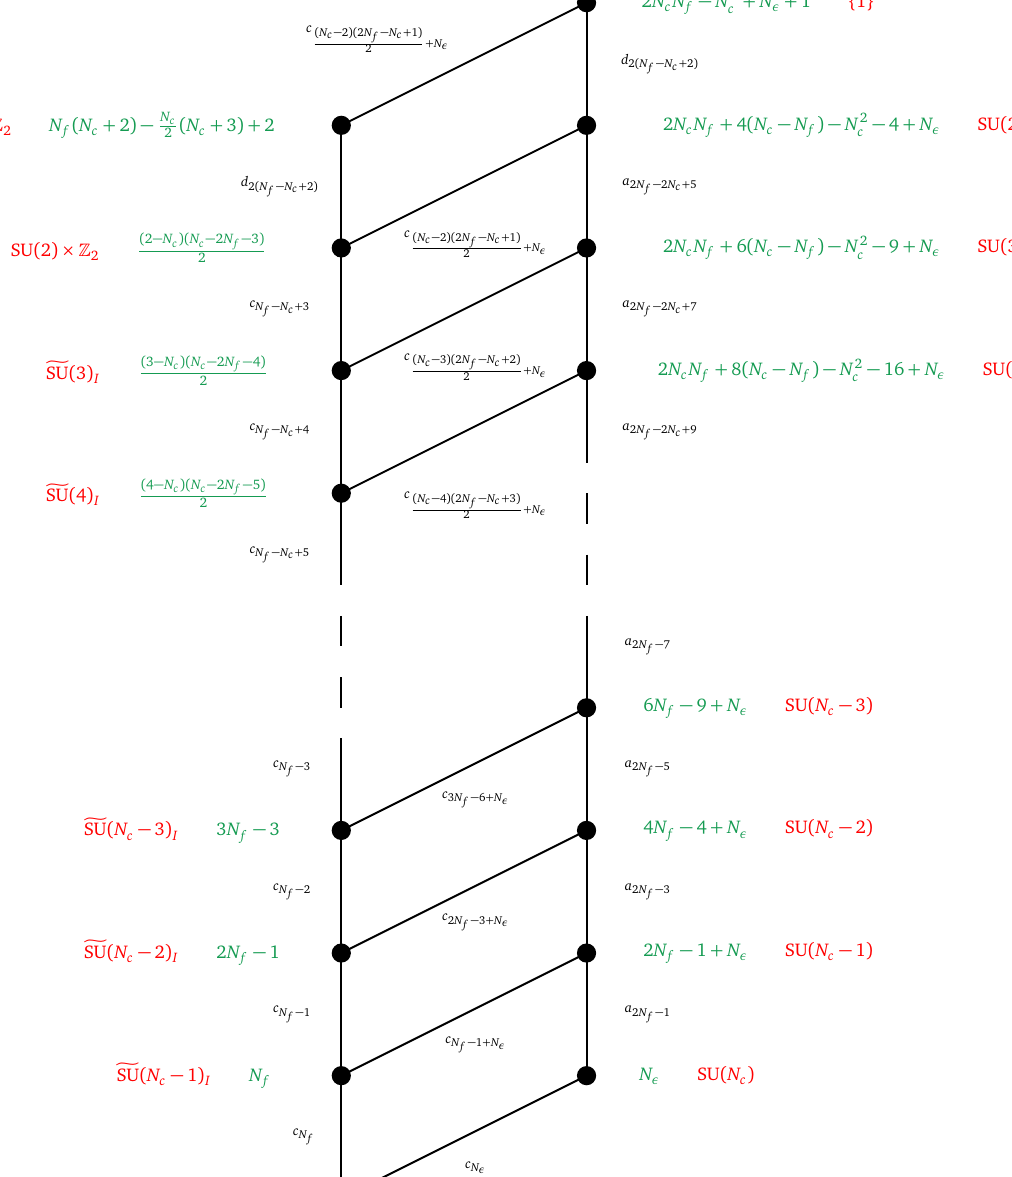
Figure 3: Higgs branch Hasse diagram of (cid:221) SU ( N The green numbers are the quaternionic dimensions of the leaves, and the red groups are the residual gauge